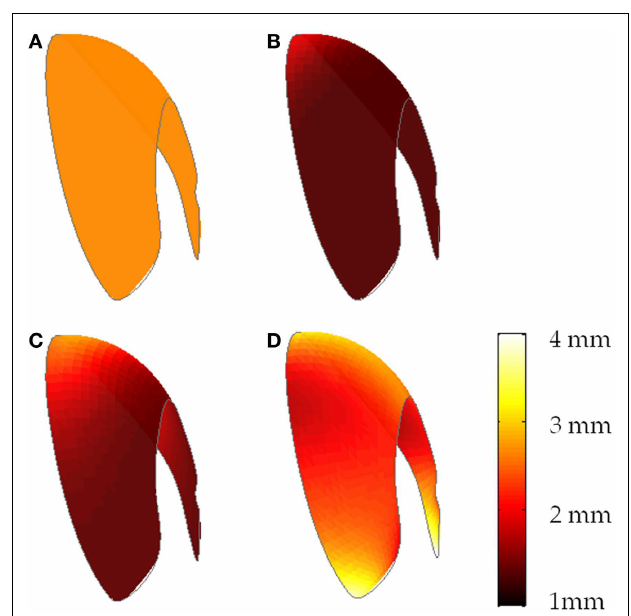
FIGURE 6 | Cartilage thickness distributions over a sample acetabular surface (frontal view) for (A) uniform thickness of 2.66mm, (B) population-based normal map, (C) population-based dysplastic map, (D) CT-based map.